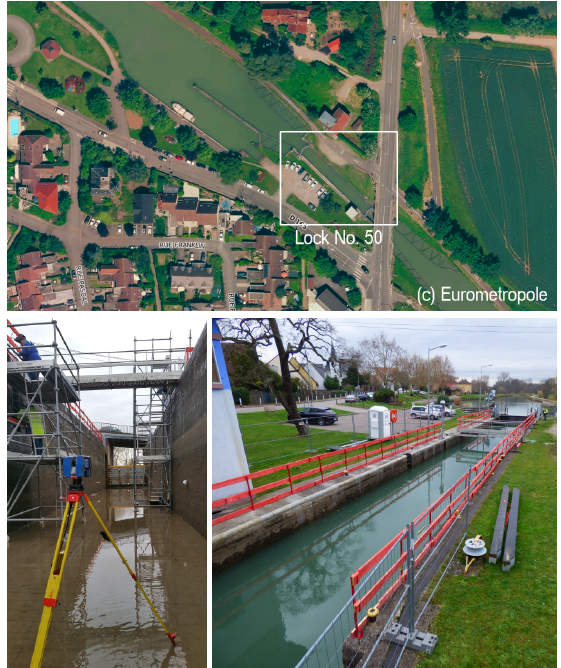
Figure 1. Top: aerial view of lock No. 50 on the Marne-Rhine canal. Bottom left: view of the lock during maintenance opera- tions and 3D TLS surveying of the chamber; bottom right: after